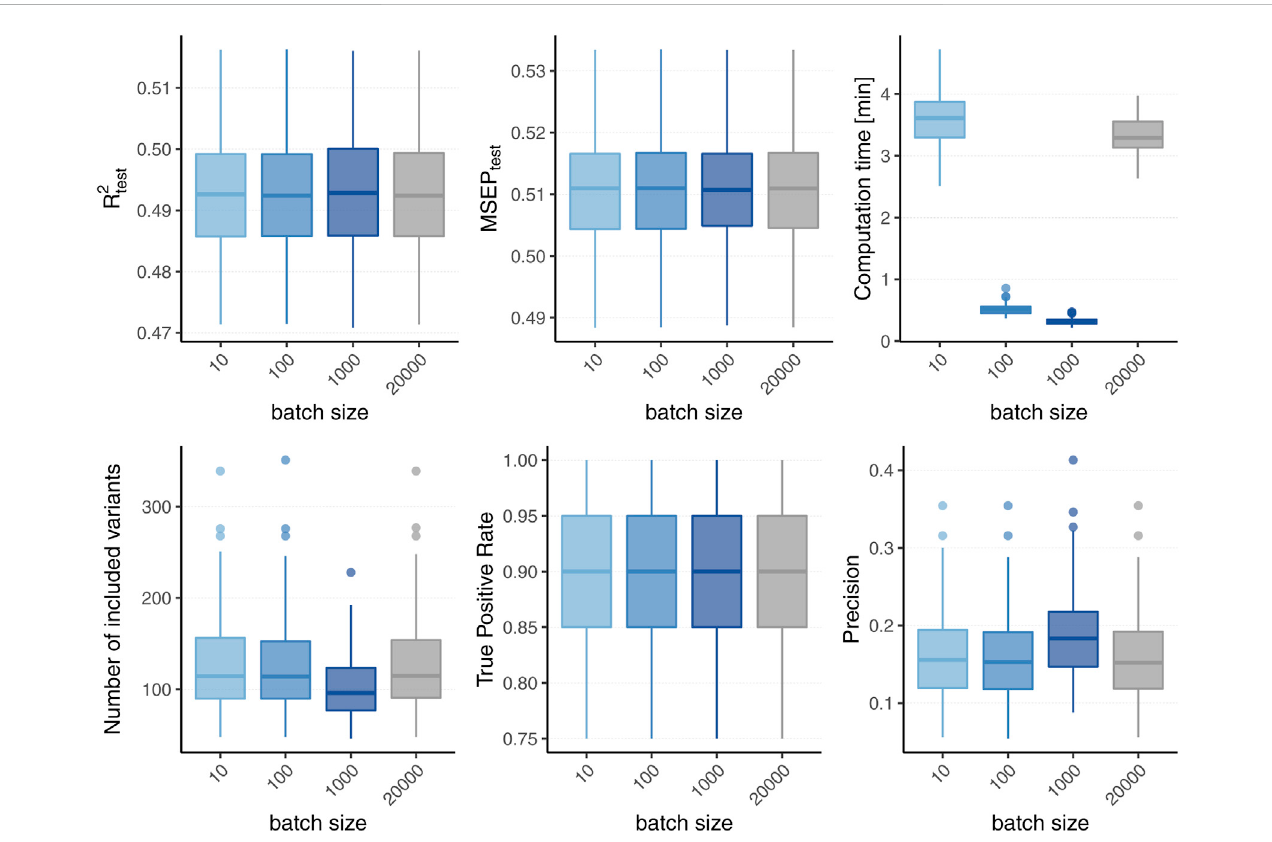
FIGURE 2 Comparison to original L 2 -boosting. Results of 100 simulated phenotypes with heritability h 2 = 50% and sparsity s = 0.1% for p = 20,000 variants and n = 20,000 individuals (divided into 50% training, 20% validation and 30% test set). Boxplots of the evaluation metrics obtained after 1,500 boosting iterations are shown depending on the batch size. Batch size p batch = 20,000 corresponds to the original L 2 -boosting (shown in